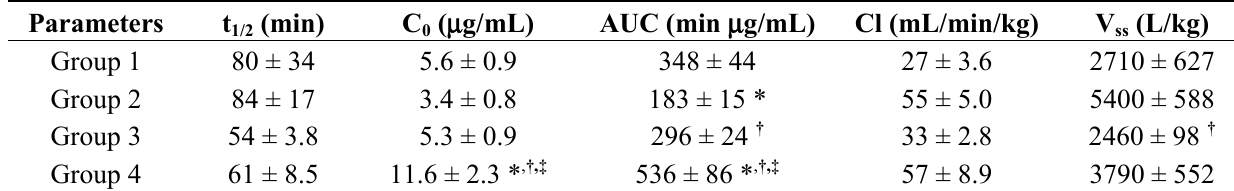
Table 3. Pharmacokinetic parameters of sildenafil in various groups.